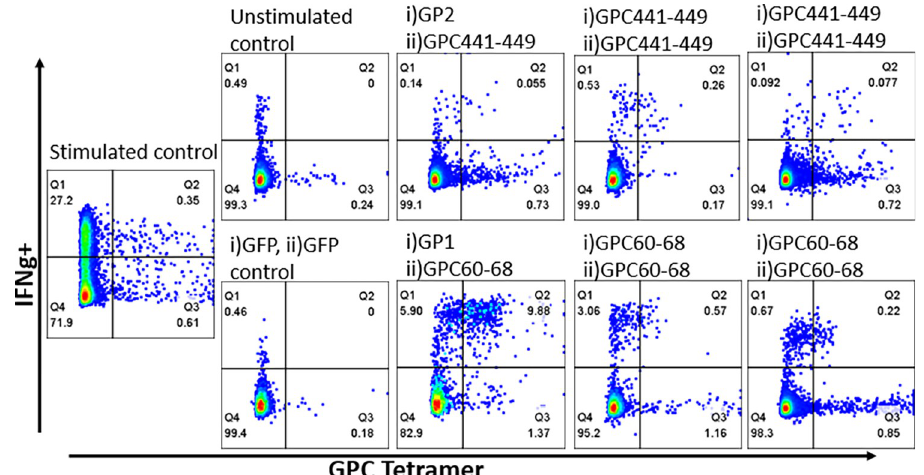
Fig 5. LF survivor’s CD8 + T cell responses to i) expansion and ii) stimulation, as denoted at the top of individual plots. On day 0, cells were expanded with either vsvGP2, vsvGP1, GPC441-449, or GPC60-68 peptides. Cells were then stimulated on day 9 with either GPC441-449 or GPC60-68 peptides. As a negative control, rscVSV-GFP was also used to expand and stimulate PBMCs. Staining included the GPC tetramer specific for the homologous peptide stimulation.